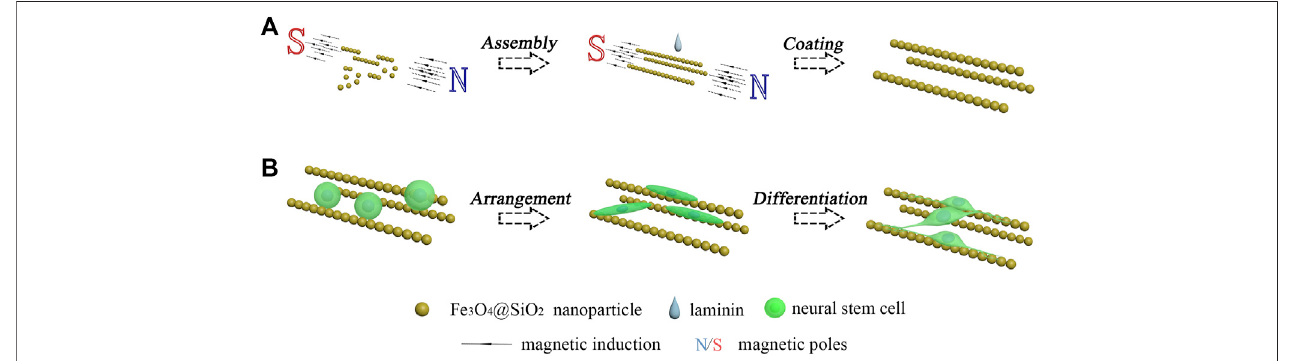
FIGURE 1 | Schematic illustration of the oriented growth of newly derived neurons. (A) Assembly of magnetic nanochains. (B) Guided oriented growth of the newborn neurons derived from the seeded neural stem